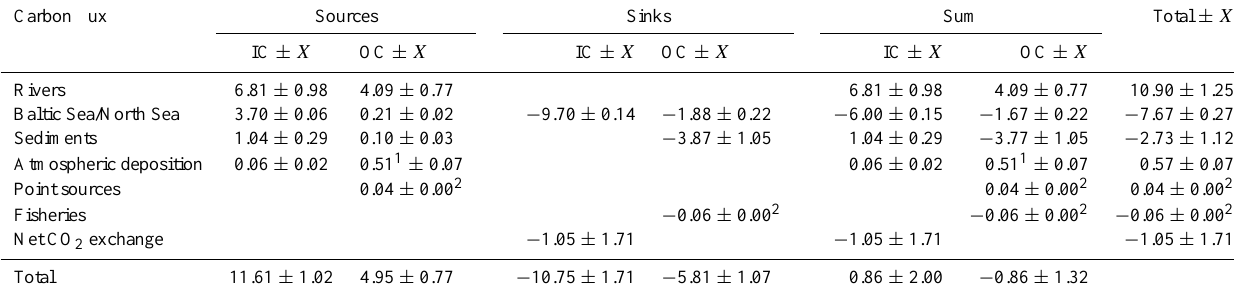
Table 2. Sources and sinks of inorganic (IC) and organic carbon (OC) expressed in TgCyr − 1 (Tg=10 12 g). Positive values indicate carbon sources, negative ones indicate carbon sinks. Carbon loads are presented with their uncertainties ( X ) calculated as the square root of the sum of squared errors of individual factors.